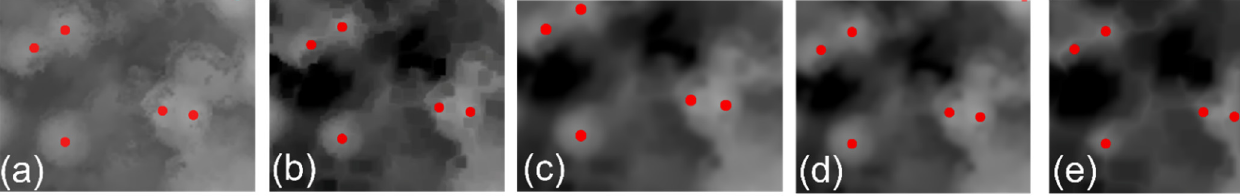
Algorithm 2. Morphological operation and treetop detection pseudocode.